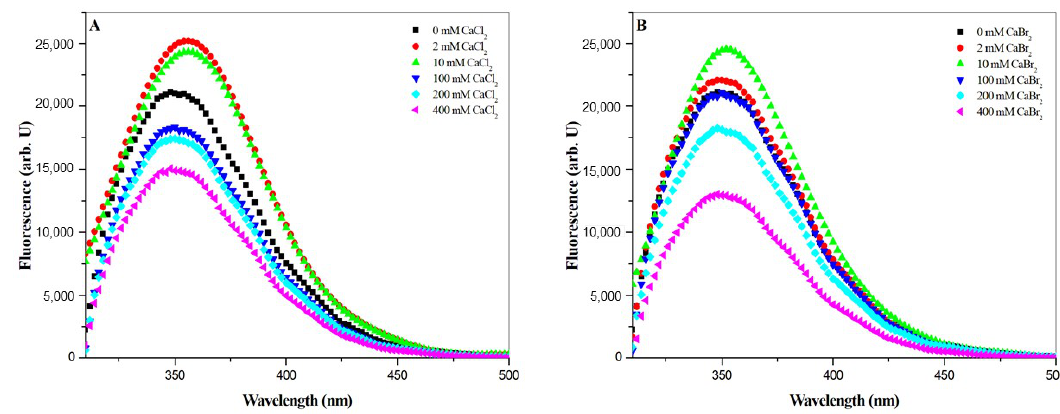
Figure 7. Steady-state fluorescence spectra of gramicidin A in the presence of ( A ) CaCl 2 and ( B ) CaBr 2 . One hundred µ M of gramicidin A titrated with CaCl 2 and CaBr 2 in methanol. In the fluorescence spectra, the concentration of CaCl 2 or CaBr2 increases from top to bottom.